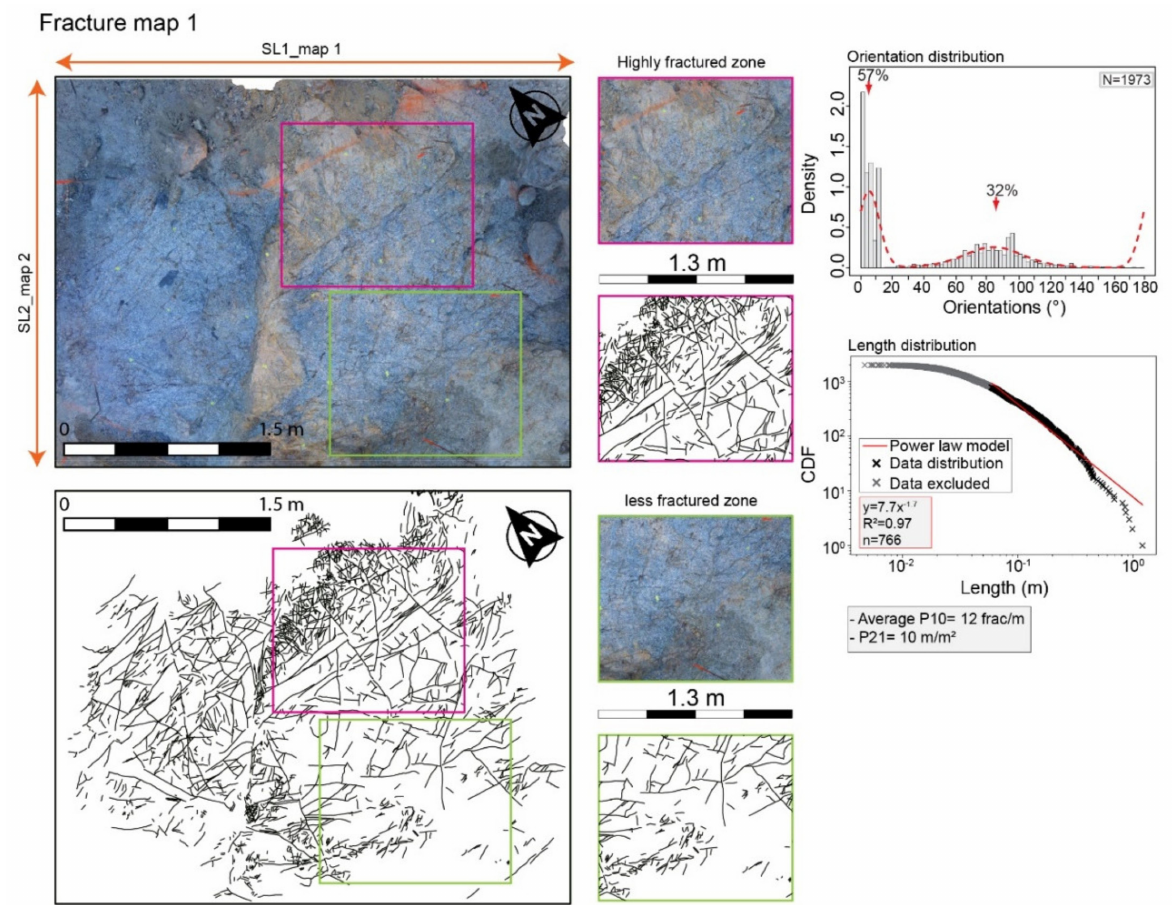
Figure 6. Fracture traces, orientation and length distributions from fracture map 1. Different datasets are expressed into histogram for orientations distribution, and into cumulative distribution function (CDF) of lengths. Two scanlines (SL) were taken for every domain. For orientation distribution legend, see Figure